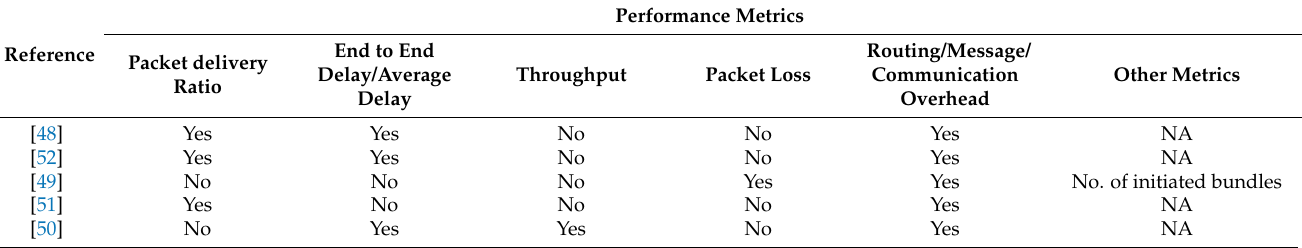
Table 13. Performance metrics of city map scenario-based routing